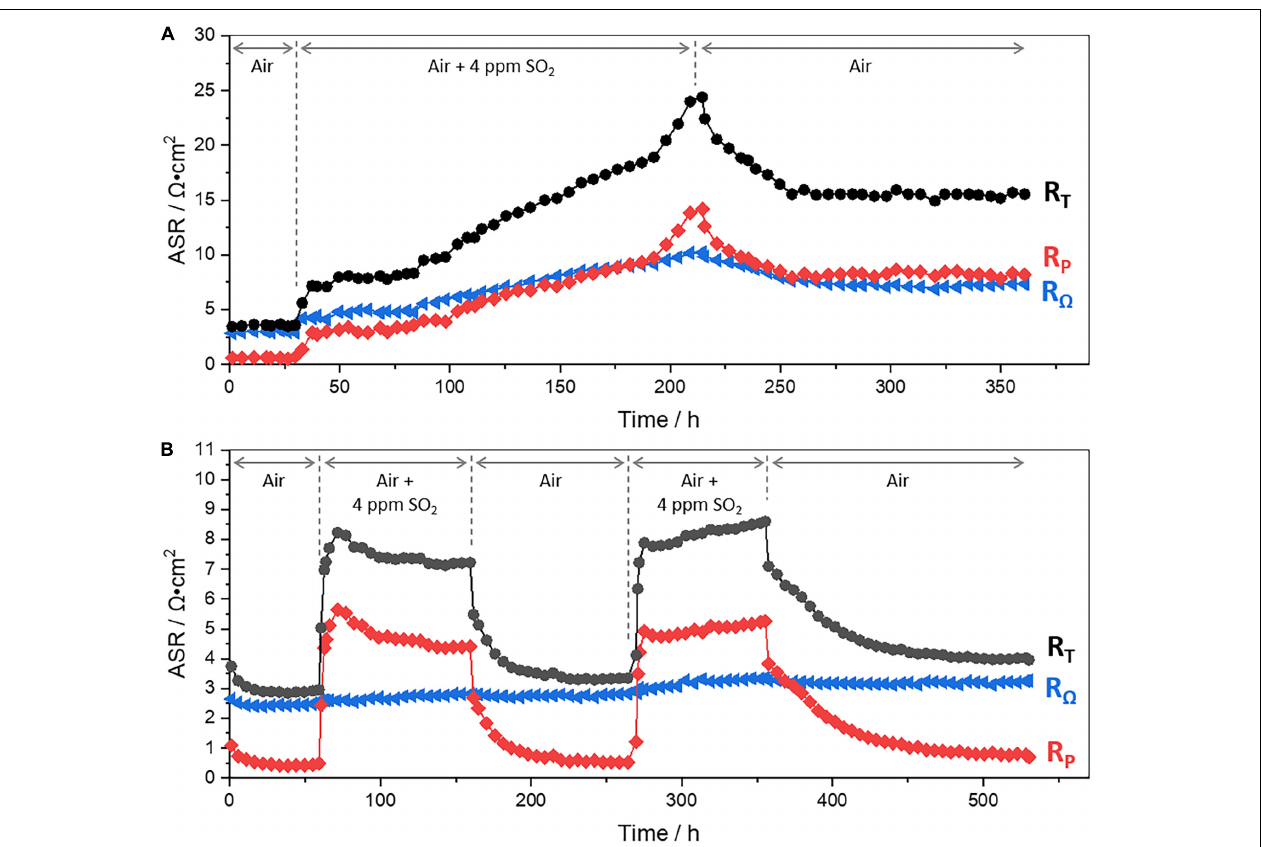
FIGURE 1 | Ohmic, polarization, and total resistances (R (cid:127) , R P , and R T , respectively) of (A) LSCF|GDC half-cell for ∼ 360 h at 700 ◦ C in alternating atmospheres of air (0–36 h and 215–358 h) and 4 ppm SO 2 ( g ) (air balance) (36–215 h), and those of (B) LSM|YSZ half-cell for ∼ 530 h at 700 ◦ C in alternating atmospheres of air (0–60, 159–268, and 354–528 h) and 4 ppm SO 2 ( g ) (air balance) (60–159 and 268–354 h). The corresponding current densities are displayed in Supplementary Figure 1